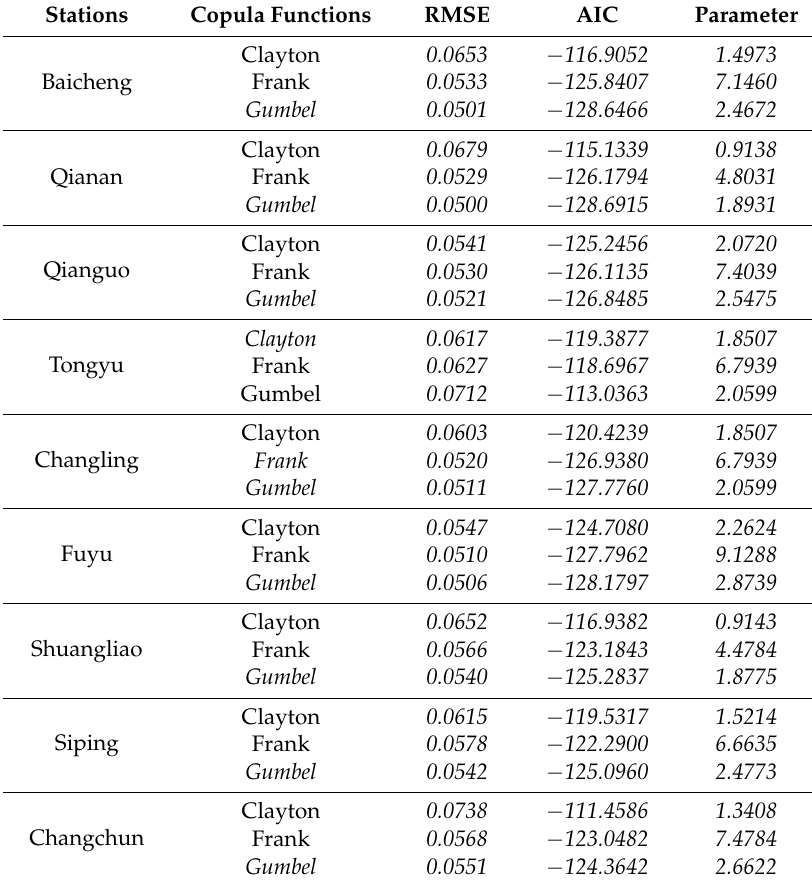
Table 4. Selection of the copula function and